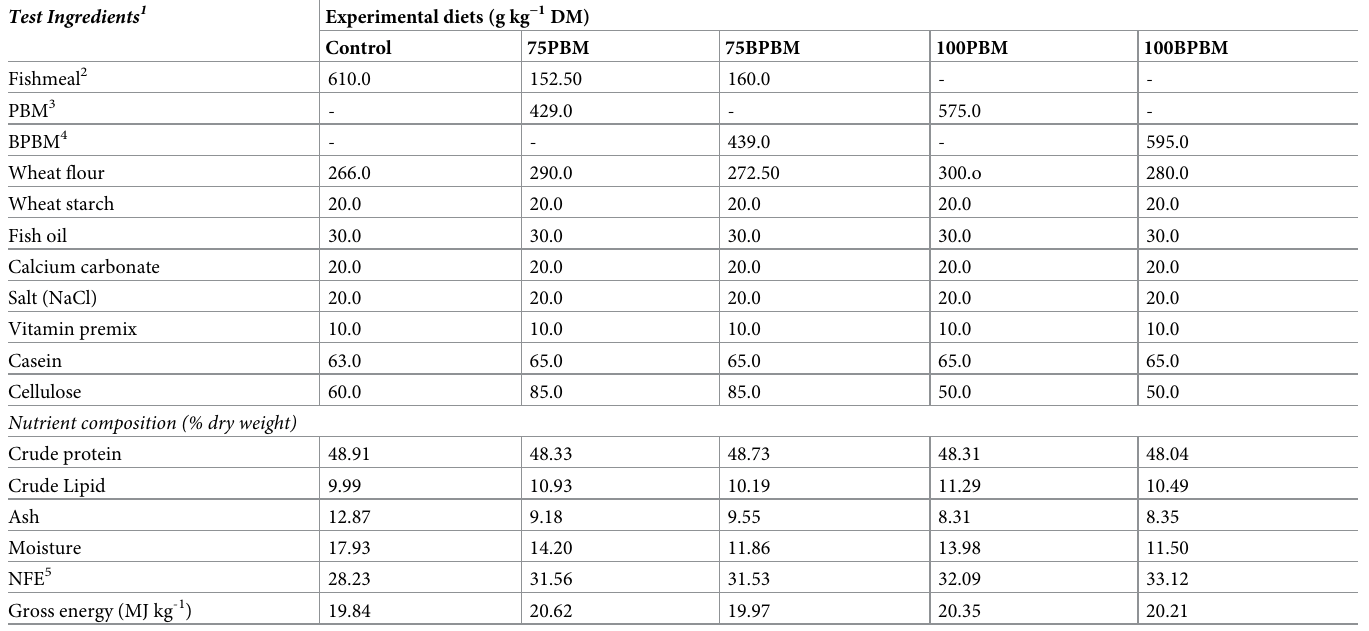
Table 1. Formulations and nutrient composition of experimental diets fed on juvenile